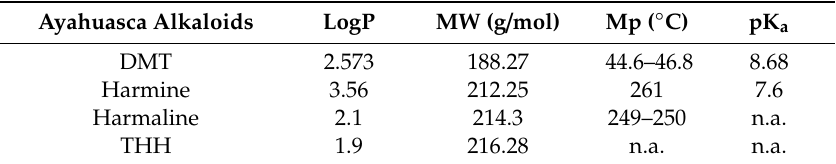
Table 2. Physicochemical properties of N , N -dimethyltryptamine (DMT), harmine, harmaline, and tetrahydroharmine